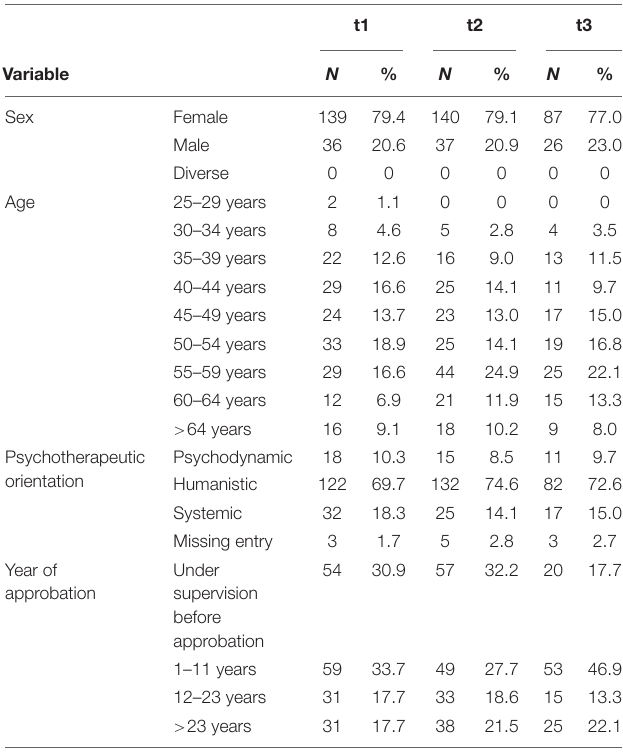
TABLE 1 | Selected sociodemographic variables of the